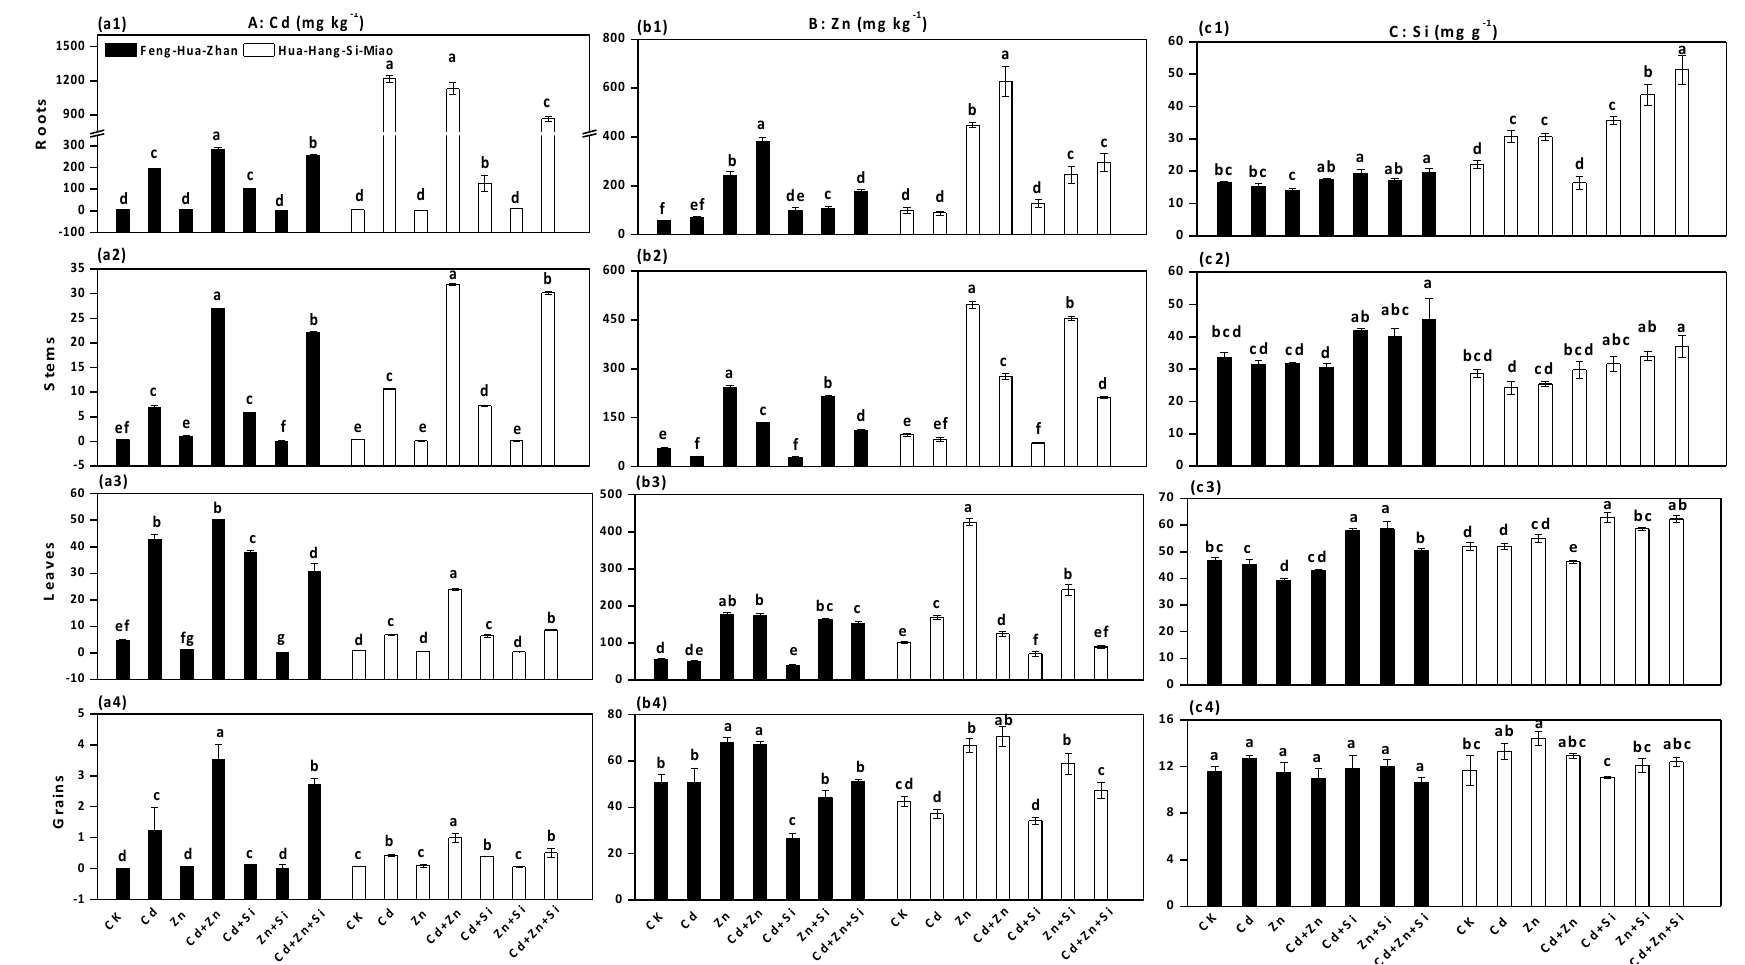
Figure+2. "Effect"of"Si"on"element"contents"in"different"rice"organs"at"the"ripening"stage:"( a1 ),"( b1 )"and"( c1 )"roots;"( a2 ),"( b2 )"and"( c2 )"stems;"( a3 ),"( b3 )"and"( c3 )"leaves;"( a4 ),"( b4 )"and"( c4 )" Figure 2. Effect of Si on element contents in different rice organs at the ripening stage: ( a1 ), ( b1 ) and ( c1 ) roots; ( a2 ), ( b2 ) and ( c2 ) stems; ( a3 ), ( b3 ) and ( c3 ) leaves; ( a4 ), ( b4 ) and ( c4 ) grains. Error bars indicate standard deviations ( n = 4). Bars with different letters are significantly different ( p < 0.05) according to Duncan’s